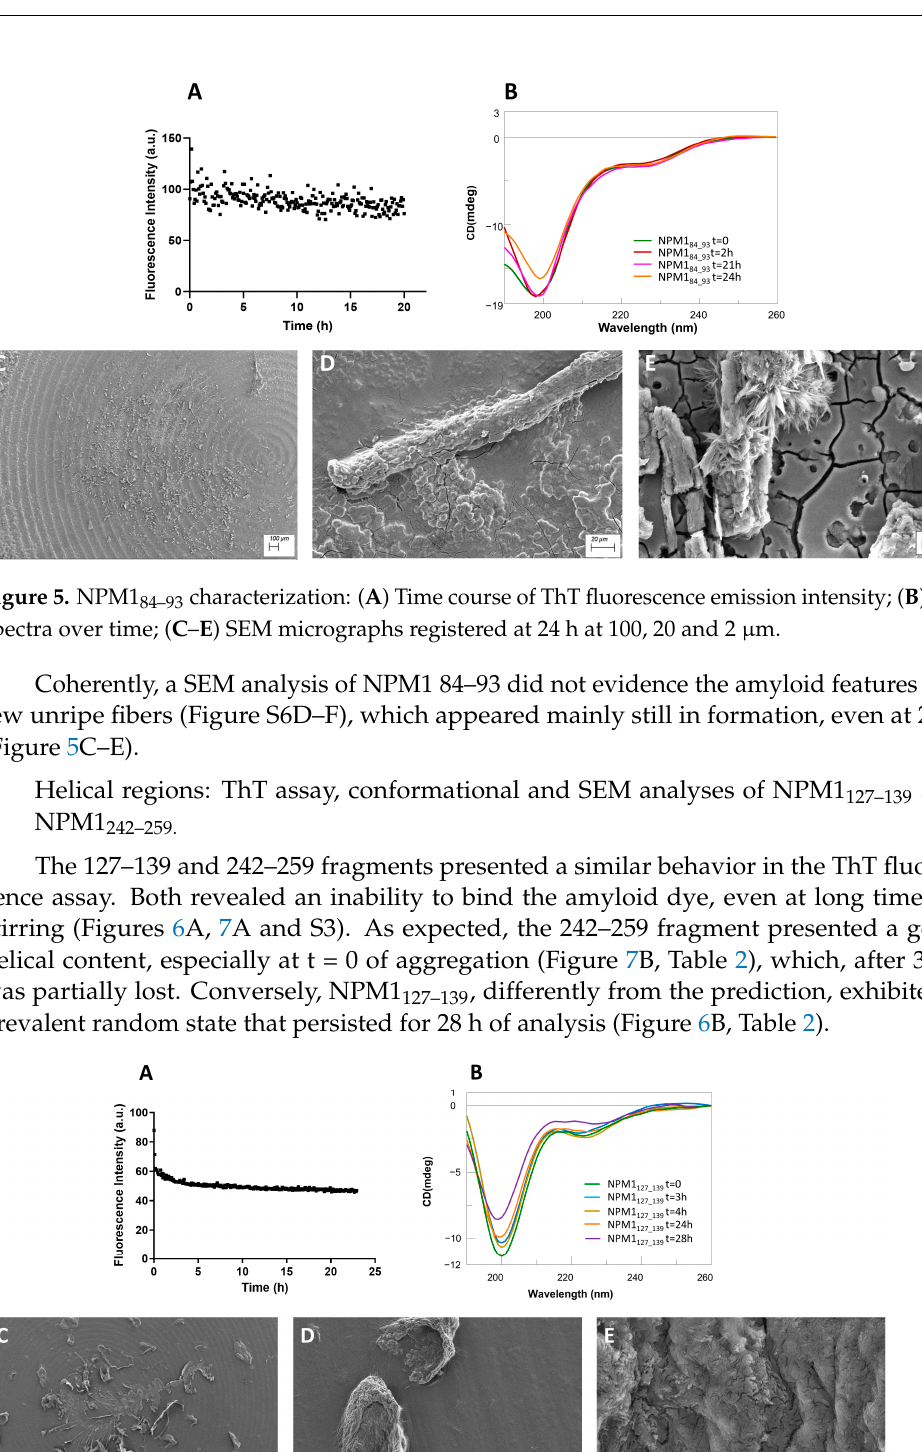
Figure 7. NPM1 242–259 characterization: ( A ) Time course of ThT fluorescence emission intensity; ( B ) CD spectra over time; ( C – E ) SEM micrographs registered at 24 h at 100, 20 and 2 µm. • Cellular effects of NPM1 fragments With the aim to evaluate the potential toxic effects of NPM1 fragments [62], several designed peptides were analyzed in a cell viability assay employing SHSY5 cells at differ- ent times of aggregation. From the MTT assay reported in Figure 8, none of the NPM1 fragments turned cytotoxic, while a slight increase in cell viability was observed at t = 0 h only for NPM1 107–120 , whereas no statistically significant effect was observed for NPM1 69– 83 .